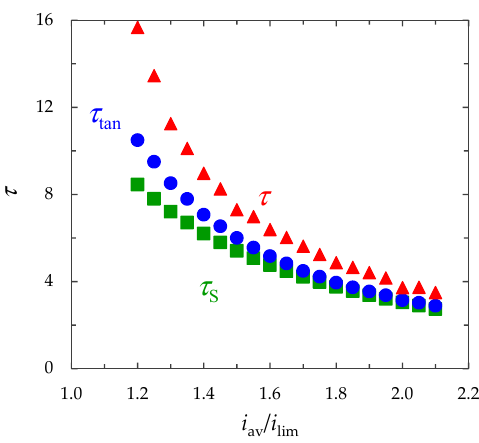
Figure 7. Transient time determined by the local maximum on ChP, τ ; by tangent to the concentration profile, τ tan ; by formula (25), τ S . The results of calculation at i av / i lim = 1.2, 1.25, …, 2.1. At underlimiting ( i av / i lim = 0.9) and limiting ( i av / i lim = 1) values of the current density, a monotonic